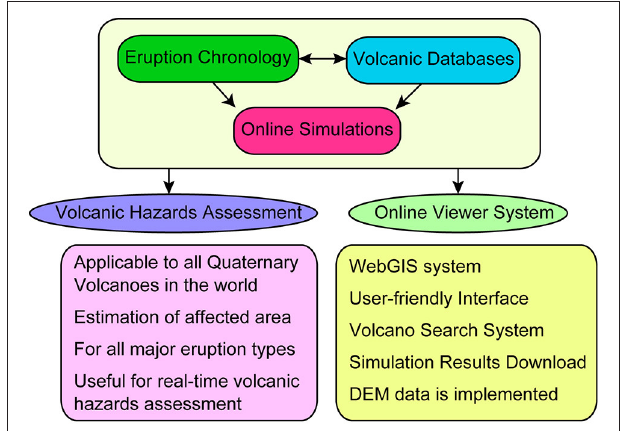
FIGURE 1 | Concept of Volcanic Hazards Assessment Support System